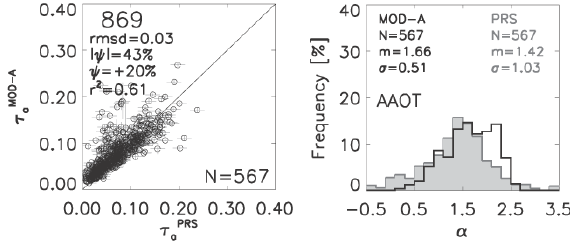
Fig. 13. Scatter plot of SeaWiFS (SWF) versus AERONET-OC (PRS) τ a (869) match-ups for the AAOT (left panel) determined with 1t =± 1h and the corresponding frequency distribution (right panel) of α determined with τ a at 765 and 869nm from SeaWiFS data and at 670 and 869nm from AERONET-OC data. Symbols are the same applied in Fig. 11.